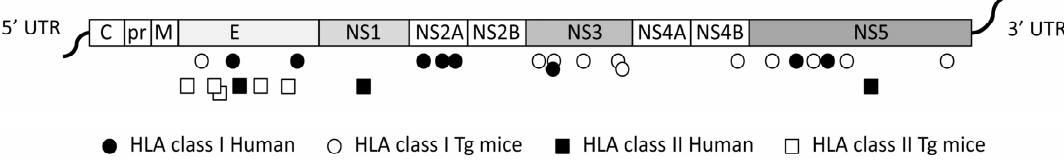
Figure 1. Schematic representation of class I- and class II-restricted cross-reactive Zika virus (ZIKV) epitopes identified in humans and transgenic mice. The ZIKV genome is not to scale. E: Envelope; HLA: Human Leukocyte Antigen; M: Protein M; NS: Non-Structural Proteins; pr: Precursor; Tg: Transgenic; UTR: Untranslated Region.